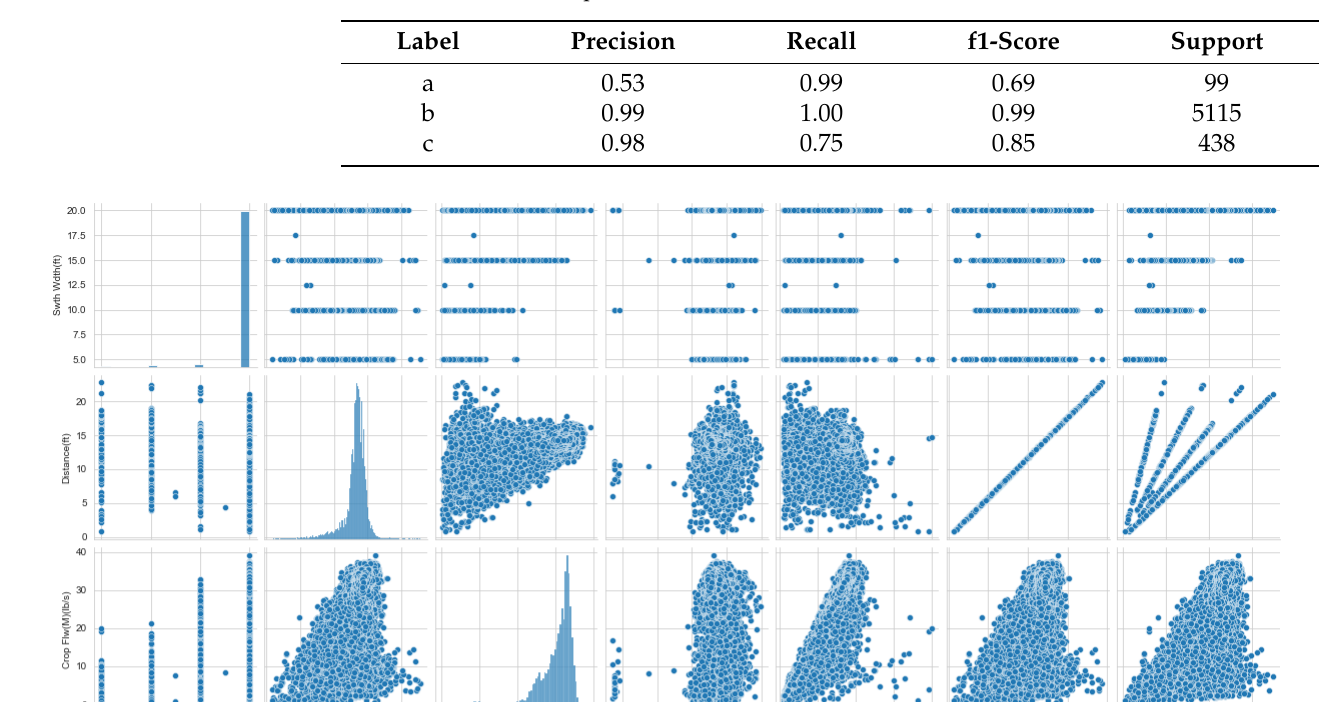
Table 1. Classification report.